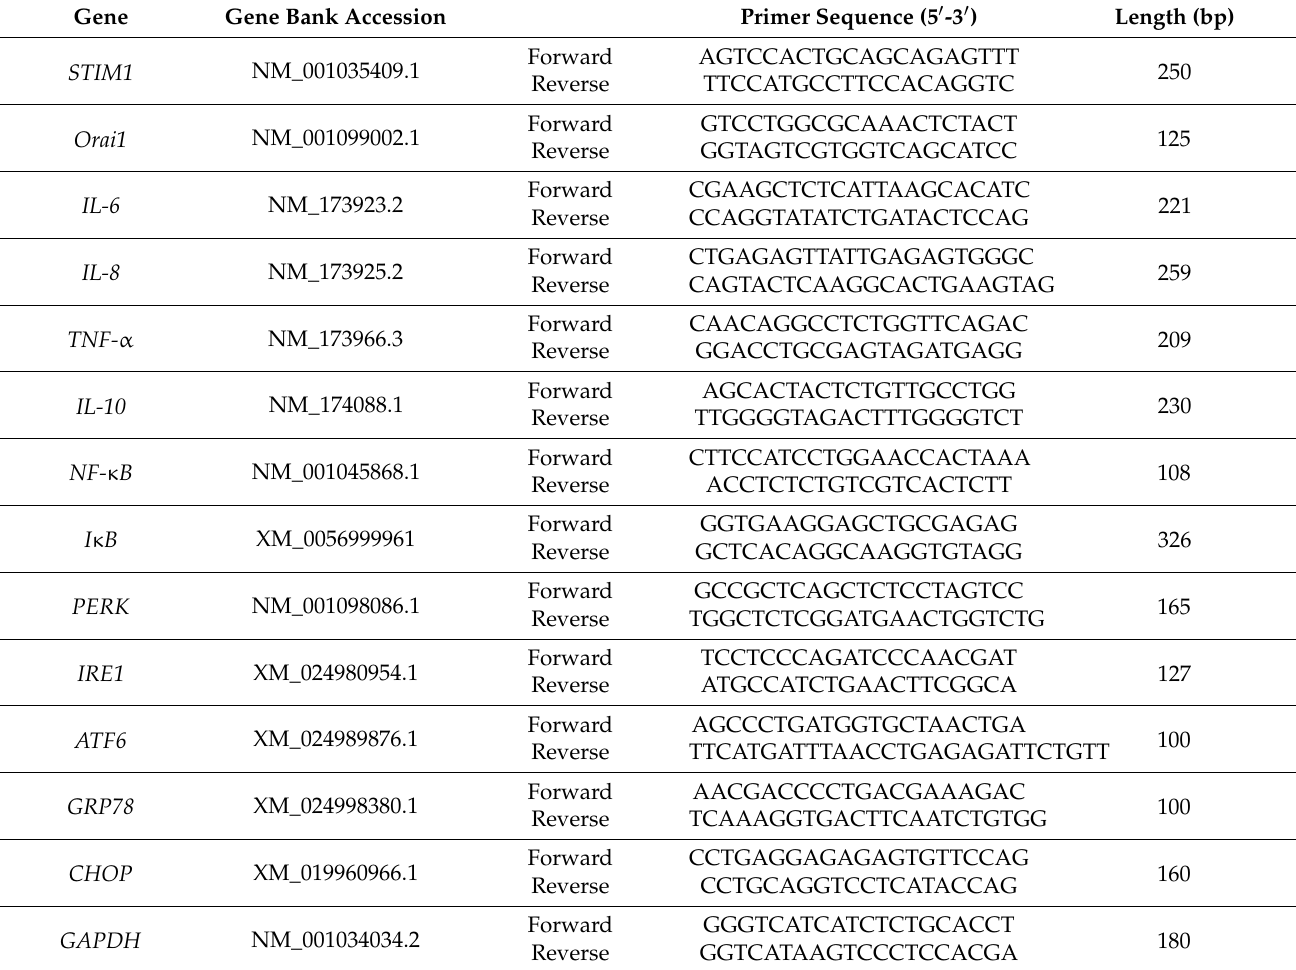
Table 1. The list of primer sequences for